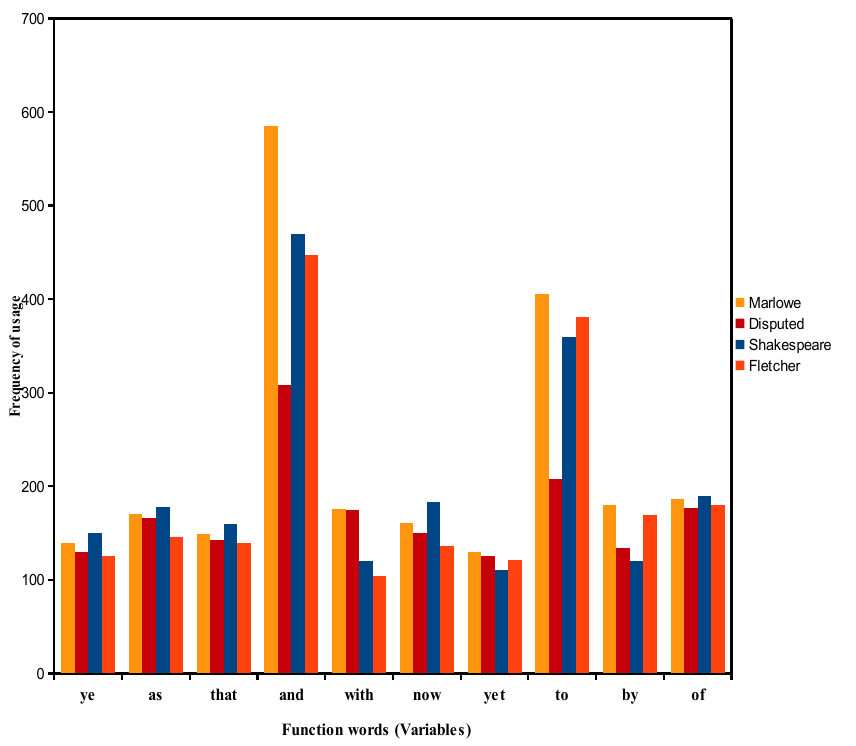
Figure 28. Function words centroid-based bar plot for Shakespeare, Marlowe, Fletcher, and the disputed texts.